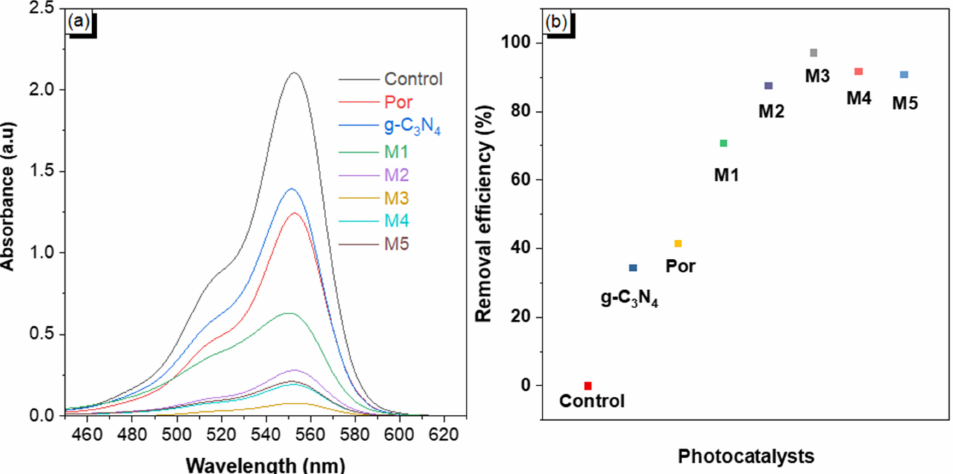
Figure 6. Effect of g-C 3 N 4 contents on the photodegradation efficiency of the hybrid material with various TCPP aggregates: g-C 3 N 4 weight ratios of 1:1, 1:2, 1:3, 1:4, and 1:6 labeled as M1, M2, M3, M4, and M5, respectively, under simulated sunlight irradiation for 100 min. ( a ) UV-vis spectra of remaining RhB concentration and ( b ) removal efficiencies with various